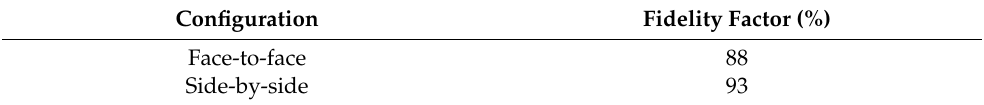
Table 2. Calculated Fidelity Factor for Side-by-Side and Face-to-Face Configurations.